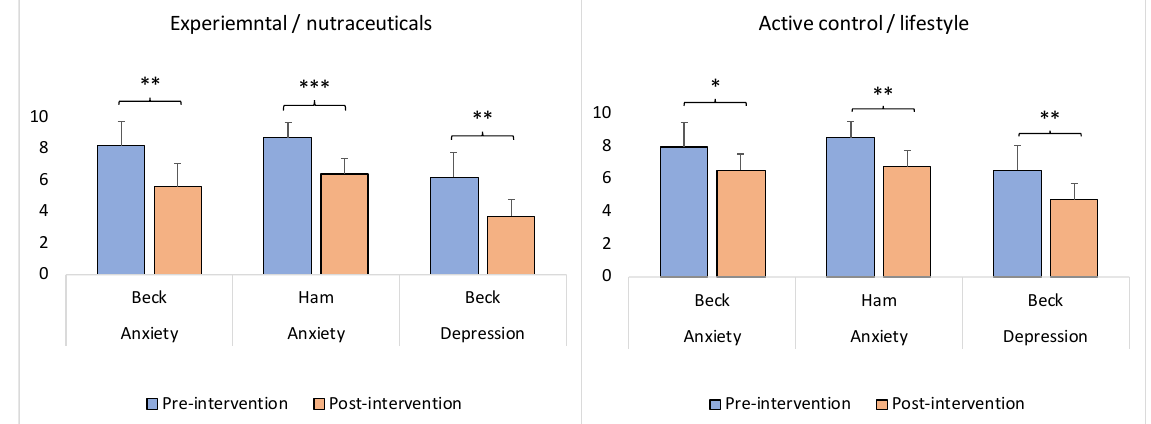
Figure 6. Intervention-induced changes in the anxiety and depression scores in the experimental (nutraceutical compounds) and active control (lifestyle) groups. The y -axis represents the standard- ized scores. Beck: Beck Anxiety Inventory [328] or Beck Depression Inventory [327]; Ham: Hamilton Anxiety Rating Scale [329]. The asterisk(s) denotes p < 0.05 (*), p < 0.01 (**), and p < 0.001 (***). The bars represent the means with standard errors.